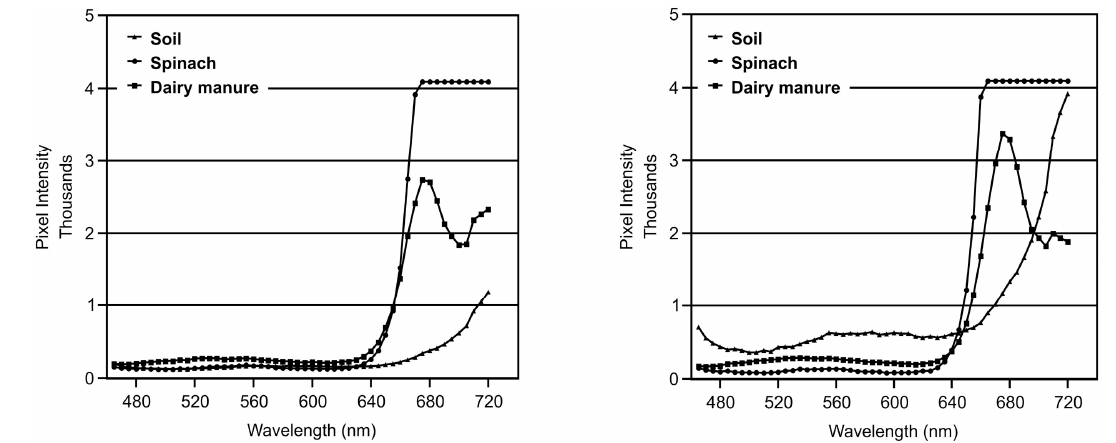
Figure 8. Spectra at gain 20 ( left ) and gain 32 ( right ) of soil, spinach, and dairy manure created using the images in Figure 7. Images were acquired near solar noon with the drape fully lowered.